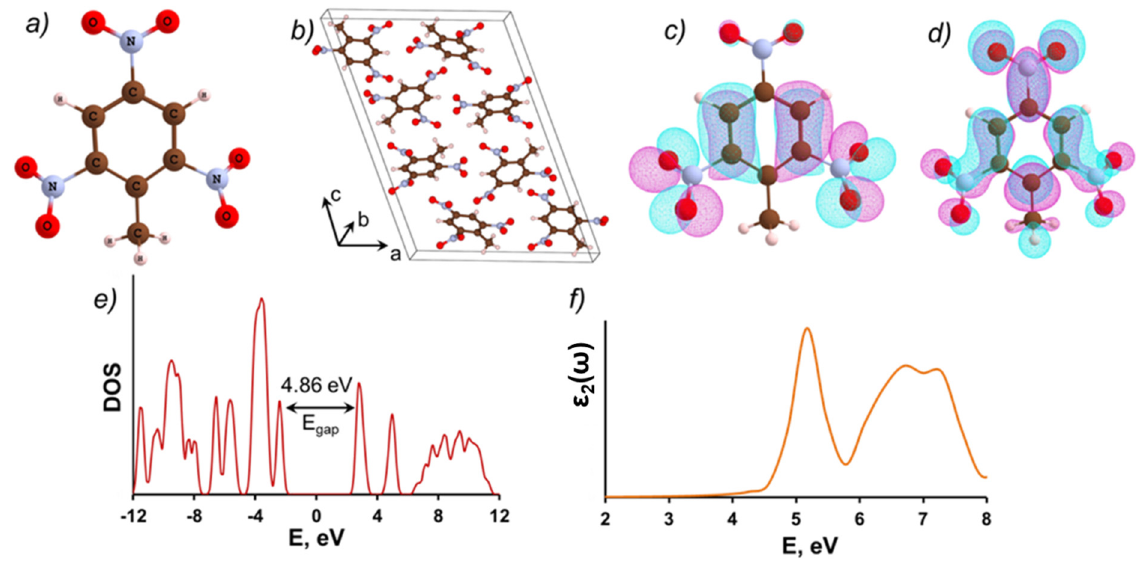
Figure 1. ( a ) The molecular and ( b ) crystalline TNT structures; the electron density distribution of the molecular TNT ( c ) HOMO and ( d ) LUMO orbitals (the isosurfaces corresponding to the coefficients with a positive sign are colored in magenta, and with a negative sign are colored in cyan); ( e ) the total density of states (DOS) of the TNT bulk crystal; ( f ) the frequency-dependent imaginary part of the dielectric function ( ε 2 ( ω )) of the TNT bulk crystal, averaged over the three crystallographic directions. Carbon atoms are shown in brown, O-in red, N-in blue, H-in white.